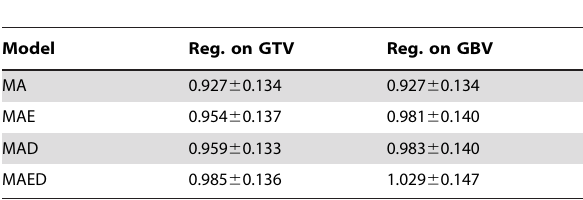
Table 5. Regression coefficients ( 6 standard errors) of corrected daily gain on predicted total genetic value (GTV) and on predicted breeding value (GBV) for the animals in the test